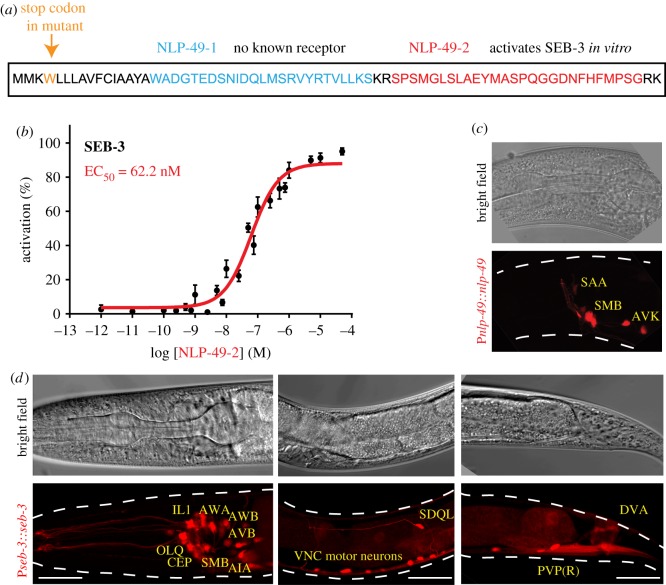
nlp-49 and seb-3 are expressed in the nervous system. (a) The peptide precursor encoded by nlp-49 contains two peptide sequences, designated NLP-49-1 (blue) and NLP-49-2 (red). The mutant allele gk546875 used in this study is a G→A missense mutation resulting in an amino acid change from W to a stop codon at position 4, resulting in the loss of expression of both peptides (https://wormbase.org). (b) Dose response curve for activation of SEB-3 by NLP-49-2 peptides (EC50 = 62.2 nM, n ≥ 9). (c) Representative micrograph showing Pnlp-49::nlp-49::SL2-mKate2 expression in SMB and AVK neurons, and putatively in the SAA neurons. (d) Micrographs of the head, midbody and tail region of animals expressing Pseb-3::seb-3::SL2-mKate2, showing the broad nervous system expression of this transgene. VNC, ventral nerve cord. Some of the neurons identified in this study are indicated; for a full list see electronic supplementary material, table S2. Scale bar, 20 µm.